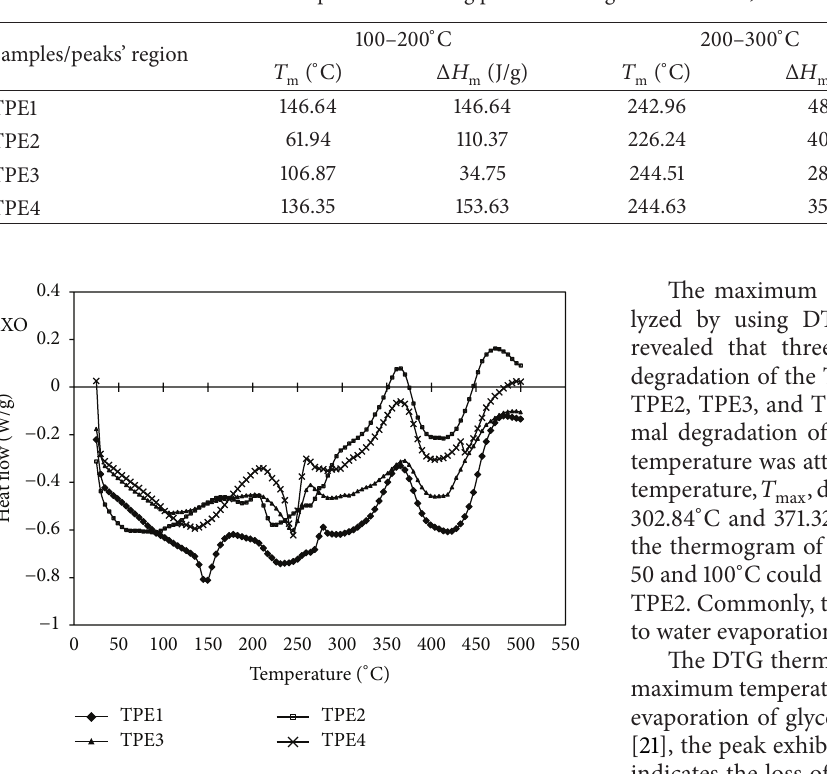
Figure 2: DSC result of TPE1, TPE2, TPE3, and